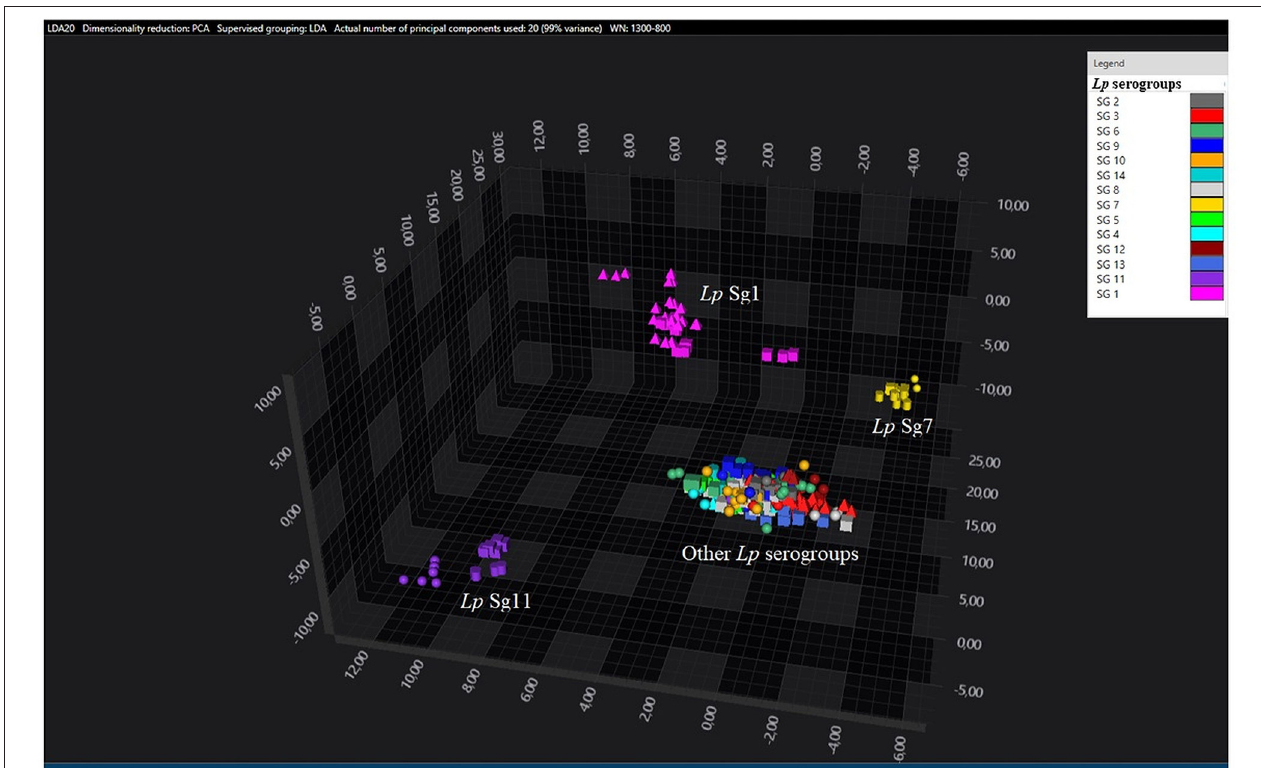
FIGURE 2 | 3D scatter plot of Lp environmental isolates. LDA was performed with 20 PCs. The single circle, triangle, or square represent one single spectrum for each isolate (technical replicates). Each serogroup is indicated by a different color. The separation of Sg1 (pink), Sg7 (yellow), and Sg11 (purple) from the other serogroups is well